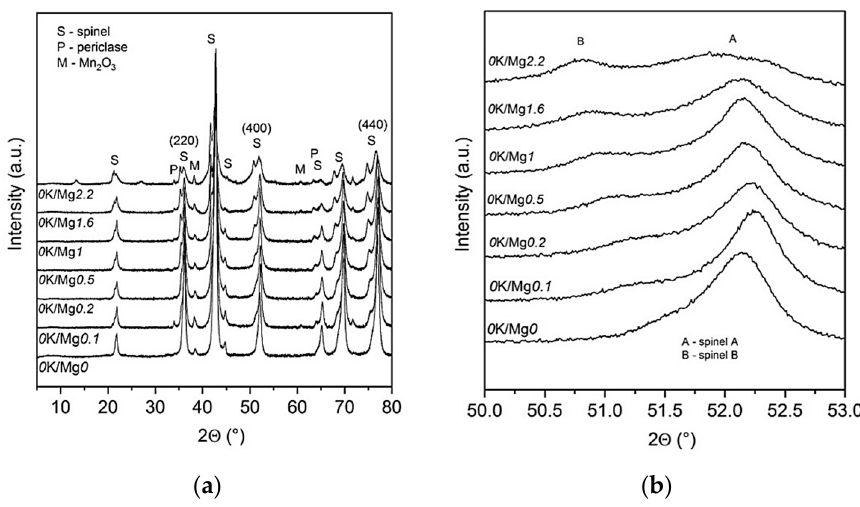
Figure 3. XRD patterns of 0K/Mgi catalysts: ( a ) from 5° to 80° and ( b ) from 50° to 53°.